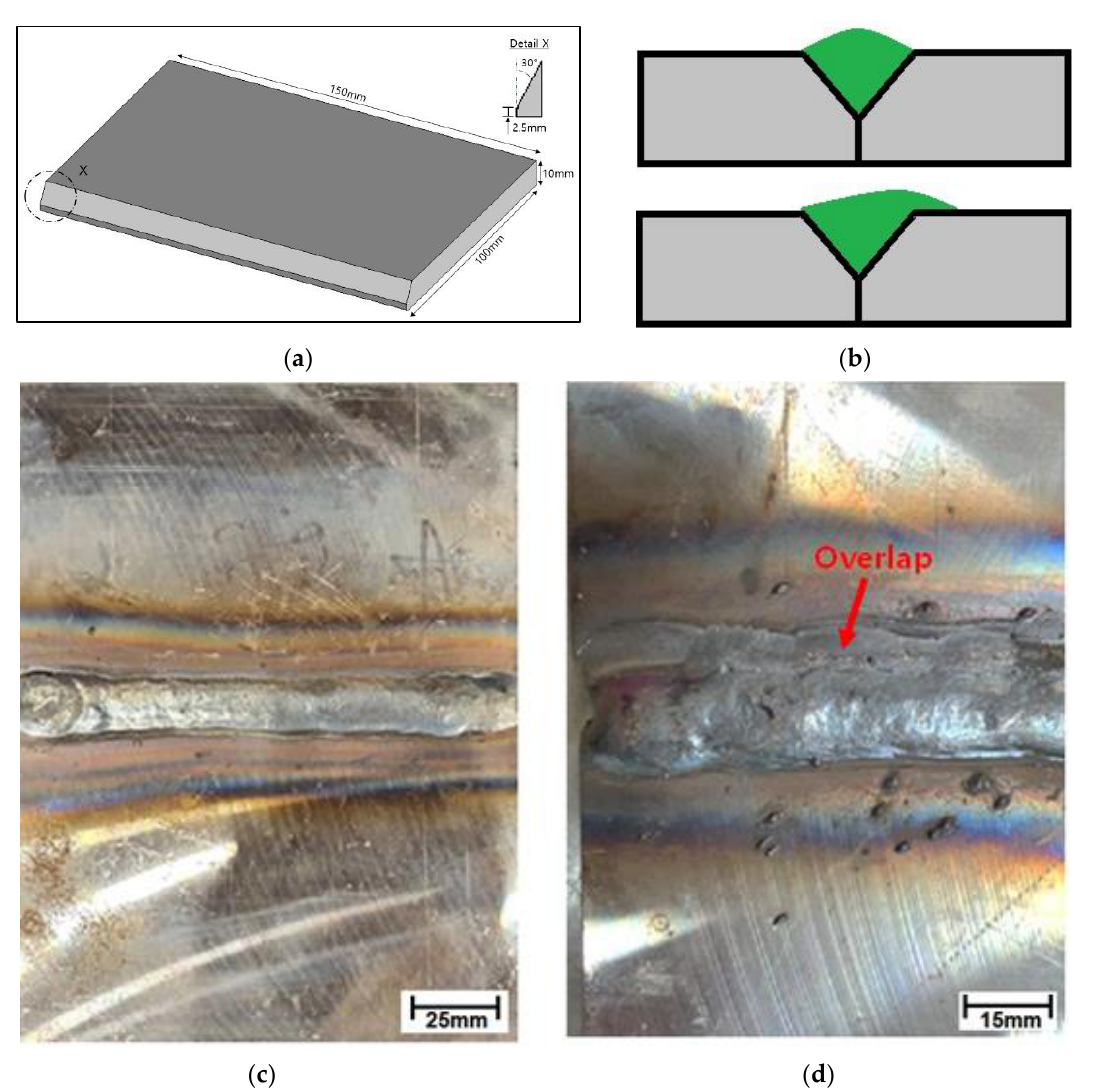
Figure 1. Weld specifications. Schematics of ( a ) cut plate for forming butt welds and ( b ) cross-section of normal weld ( top ) and overlap weld ( bottom ); Photographs of ( c ) normal welded plate and ( d ) welded plate with overlap defect.